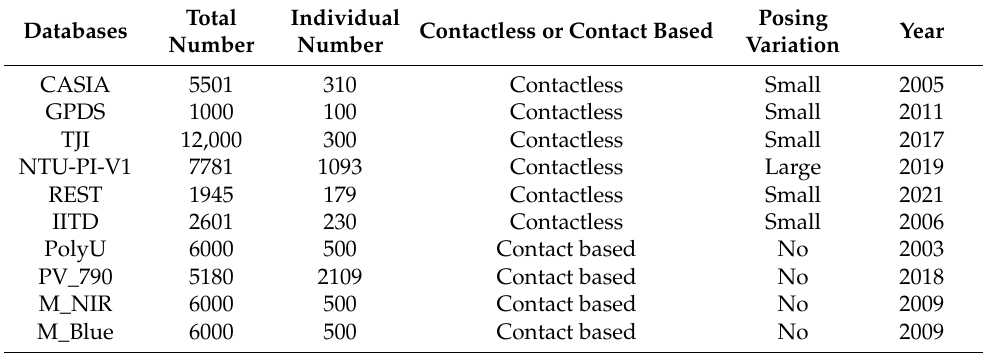
Table 1. Detailed descriptions on different types of palmprint